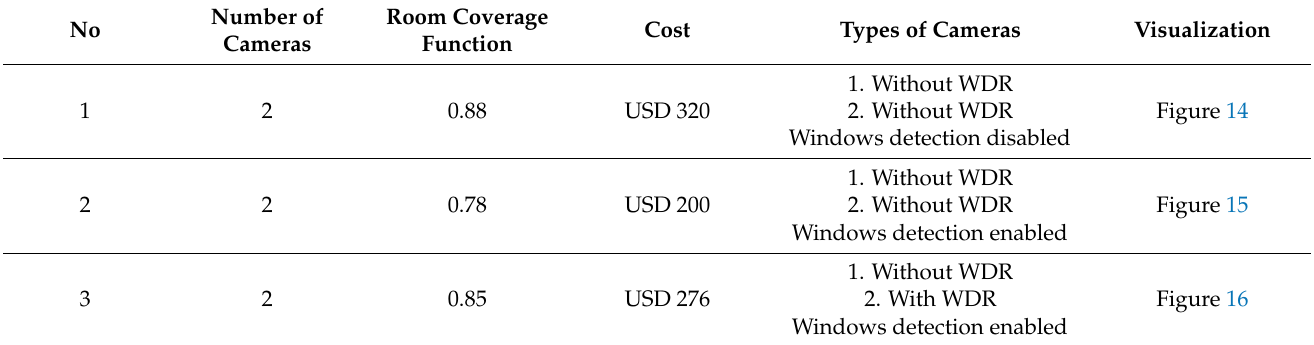
Table 9. The comparison of the optimal solutions found.